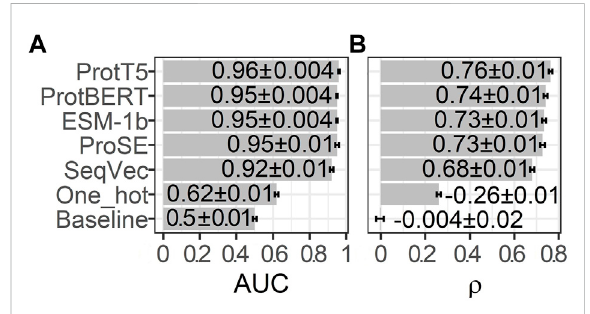
FIGURE 1 Performance estimates for training on 90% of CheZOD1174 (Dass et al., 2020) and testing on the remaining 10% using linear regressions fed by 20-dimensional one-hot encodings or raw embeddings (without further optimization) from fi ve protein language models (pLMs): ProtT5 (Elnaggar et al., 2021), ProtBERT (Elnaggar et al., 2021), ESM-1b (Rives et al., 2021), ProSE (Bepler and Berger, 2021), SeqVec (Heinzinger et al., 2019). The seventh row displays the performance of the baseline/random model computed on 1024-dimensional embeddings sampled randomly from a standard normal distribution. (A) required to fi rst project predictions onto a binary state of disorder (CheZOD score ≤ 8)/ order (CheZOD score > 8) and measures the area under the receiver operating characteristic curve (AUC; Eq. 3), while (B) depicts the Spearman correlation coef fi cient ( ρ ; Eq. 2), calculated using the observed and predicted CheZOD scores. The errors mark the 95% con fi dence intervals approximated by multiplying 1.96 with the bootstrap standard deviation (Methods).